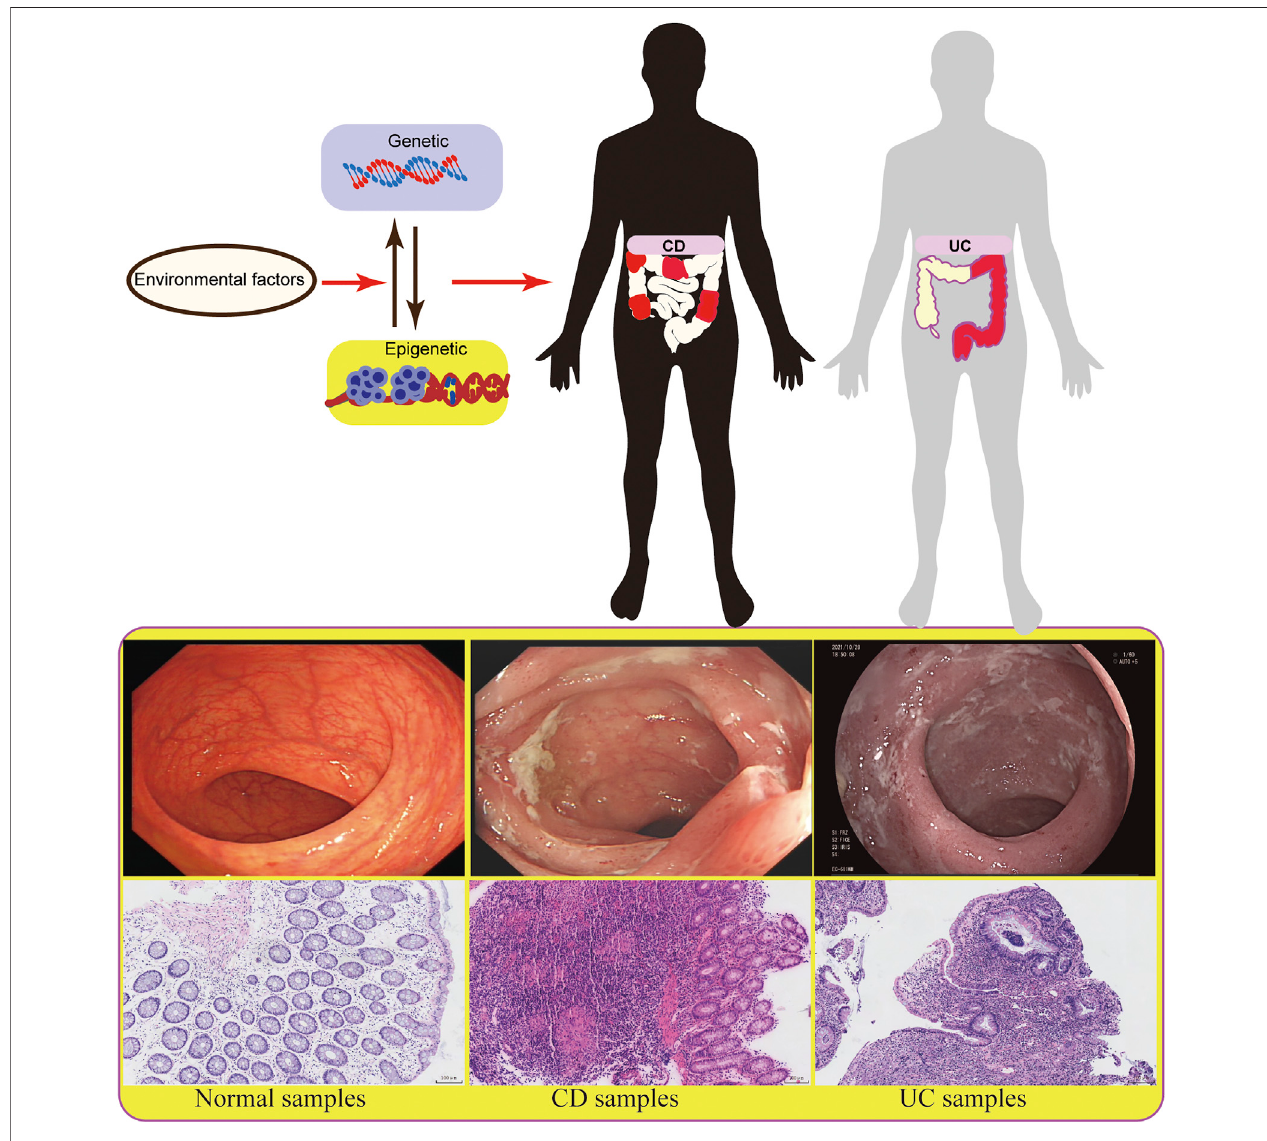
FIGURE 1 | The diagram shows different factors of epigenetics in